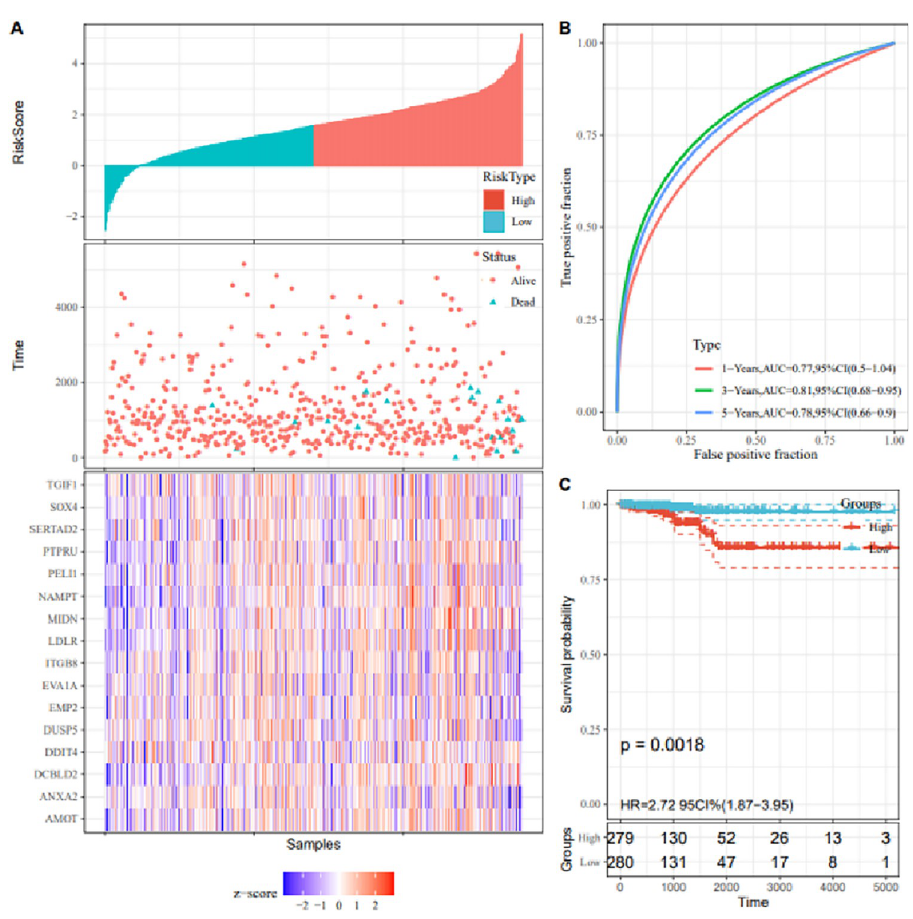
Fig 5. Survival prediction model for screening hub-mRNAs. (a)The scatter plots of overall sample distribution, risk score plots, and gene expression heatmaps for high-risk and low-risk categories.The majority of death samples have high risk factors (b)The ROC curves based univariate Cox regression. (c) Survival curves of the high-risk and low- risked.